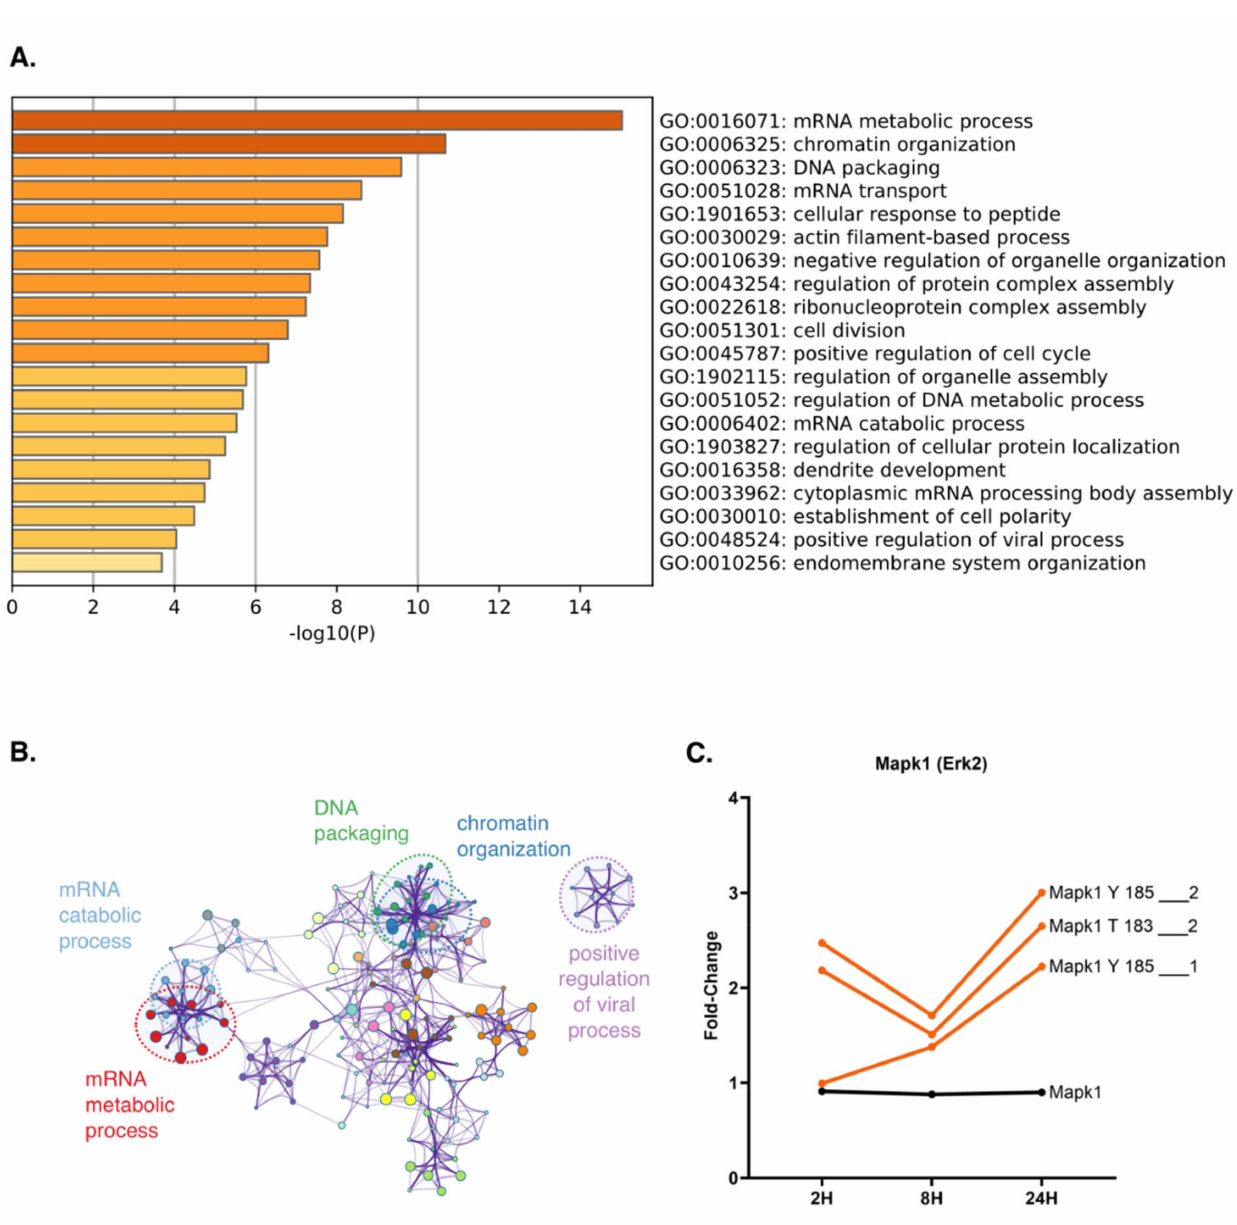
Figure 5. TNF α upregulates phosphorylation of proteins involved in DNA replication and cell cycle control. ( A ) Gene ontology analysis of biological processes regulated by proteins upregulated by TNF α at 24H compared with 0H. Here, analyzed proteins are represented in the cluster highlighted by the green line in Figure 4B. ( B ) String representation of functional classifications upregulated by TNF α at 24H compared with 0H. Specific clusters for relevant GO terms are observed, represented by different colors. ( C) Fold-change analysis between site intensities at each time point relative to 0H (orange) compared with the fold-change in total protein levels at each time point relative to 0H (black). Phosphosites are labeled according to the phosphorylated residue, and its position and